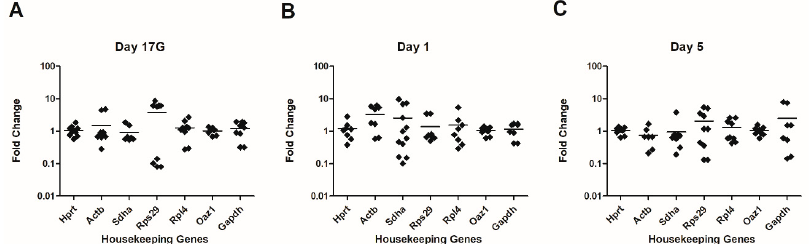
Figure 1. Fold change in HKG expression in the developing mouse thymus. mRNA was extracted and converted to cDNA. The cDNA was subjected to real-time quantitative PCR using gene-specific primers for seven selected HKGs. Expression variability of each HKG in thymuses ( n = 7–12), sampled from fetuses at Day 17 of gestation (Day 17G) ( A ), and newborns at Day 1 ( B ) and Day 5 ( C ) from birth, is represented by log-scale of fold change (lines represent a median). The fold change represented was calculated using the equation presented by Livak and Schmittgen, 2001 [20]: Fold difference = 2 −Δ Ct.